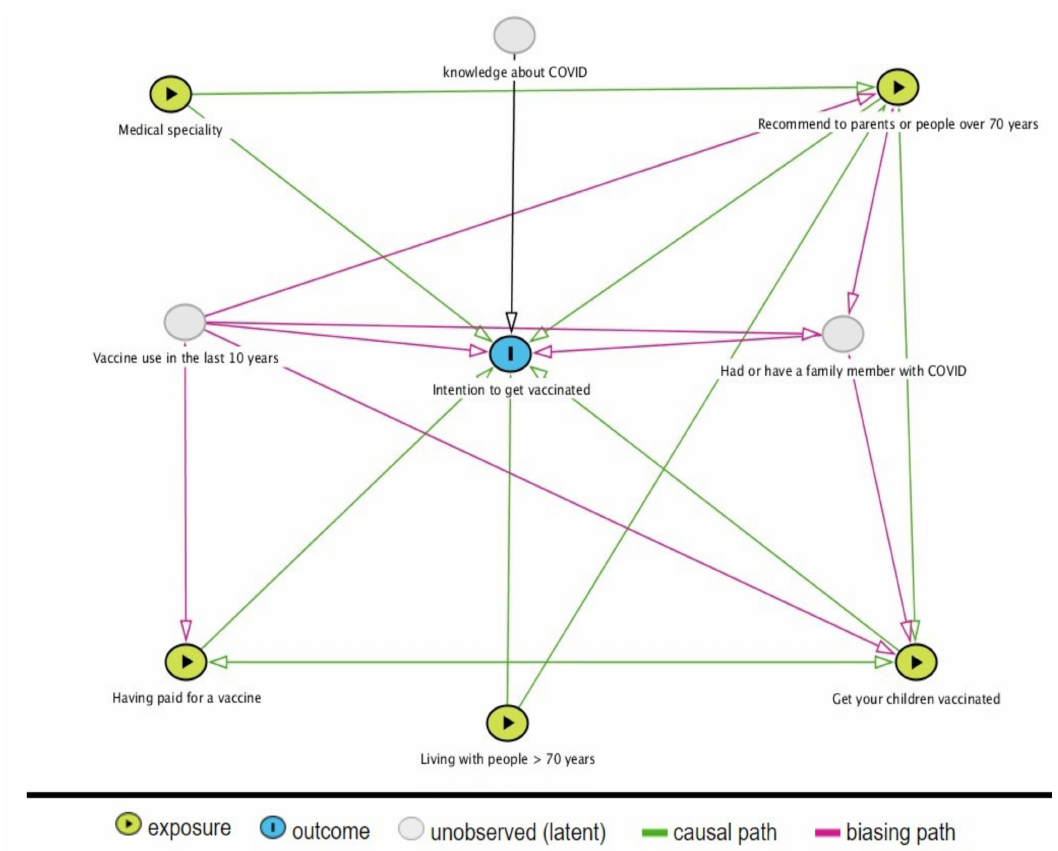
Figure 3. A causal diagram to represent the association between the intention to get vaccinated and the medical specialty, having paid for a vaccine, living with people over 70 years of age, giving their children the vaccine, and recommending vaccination to parents or those over 70 years of age, adjusting for potentially confusing variables. Source: Own elaboration through the website: http://www.dagitty.net/development/dags.html (accessed on 1 February